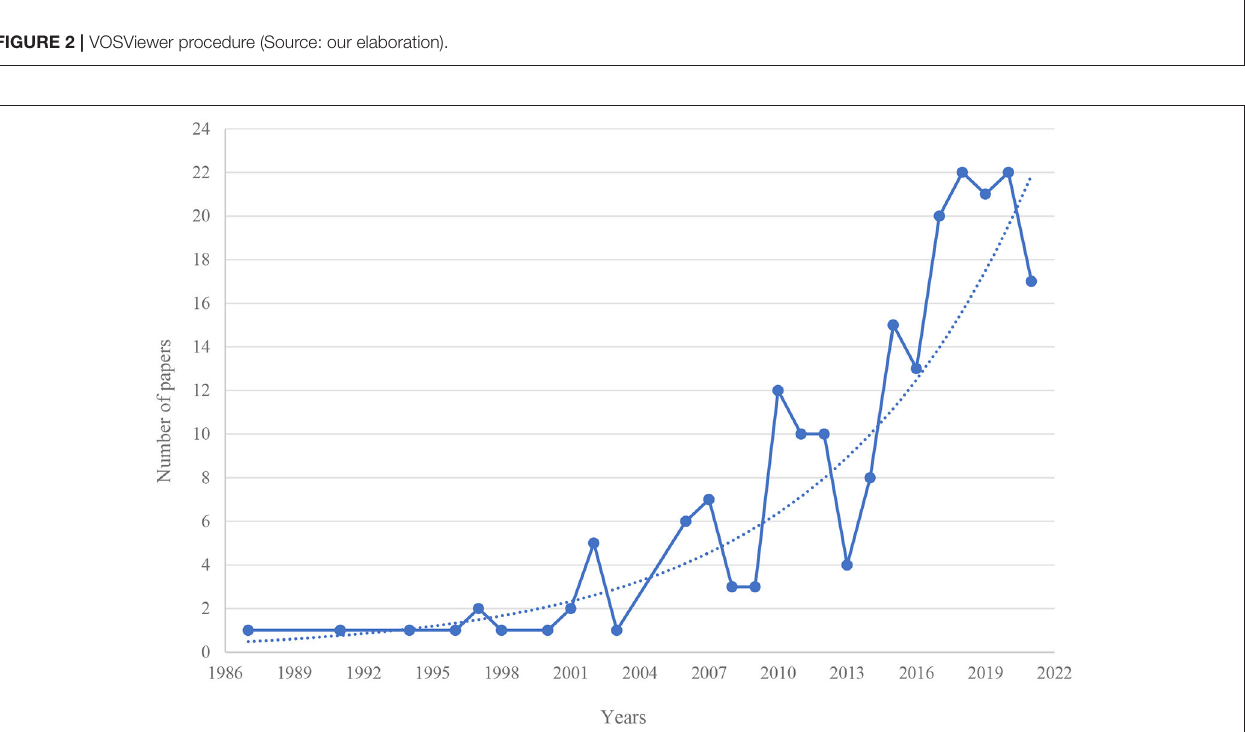
FIGURE 3 | Number of papers per year (Source: our